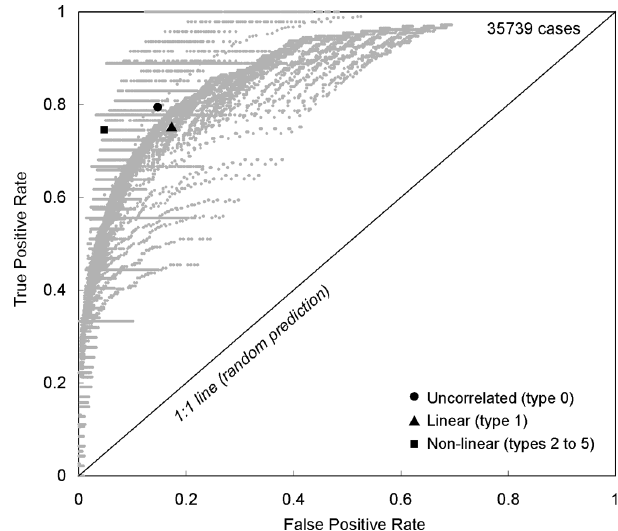
Fig. 7. Results of the ROC curve analysis (Green and Swets, 1966) for the calibration of the statistical thresholds used in PS-Time ( α 1 , α 12 , B th ) . Each point indicates the accuracy of the automatic classi- fication obtained by a given combination of the statistical thresholds with respect an expert-based classification. Black marks indicate the accuracy of the best combination found ( α 1 = 0 . 01, α 12 = 0 . 01, and B th = 1 . 0 )